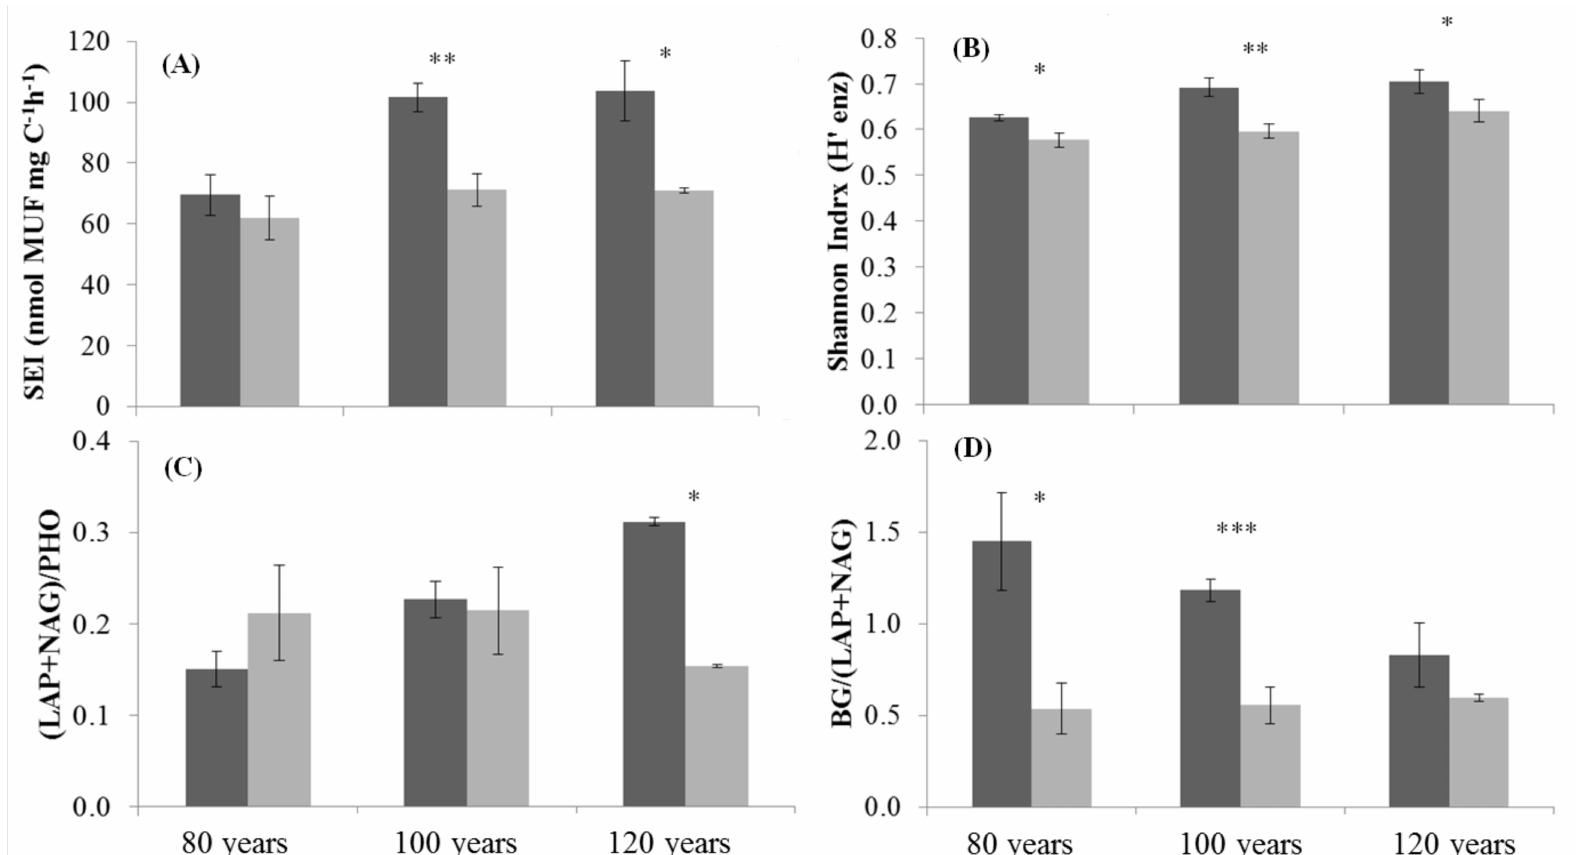
Figure 6. Soil biochemical properties of epipedon (dark grey) and endopedon (light grey) along the Douglas fir stand chronosequence: Synthetic Enzymatic Index per unit of organic carbon (SEI) ( A ) microbial functional diversity (H (cid:48) enz) ( B ), Leucine-amminopeptidasi + chitinase to phosphatase ratio ( C ), β -glucosidase to Leucine-amminopeptidasi + chitinase ratio ( D ). Bars are standard errors, asterisk indicate significant difference (* p < 0.05, ** p < 0.01, *** p < 0.001) between epipedon and endopedon at each stand age ( n =